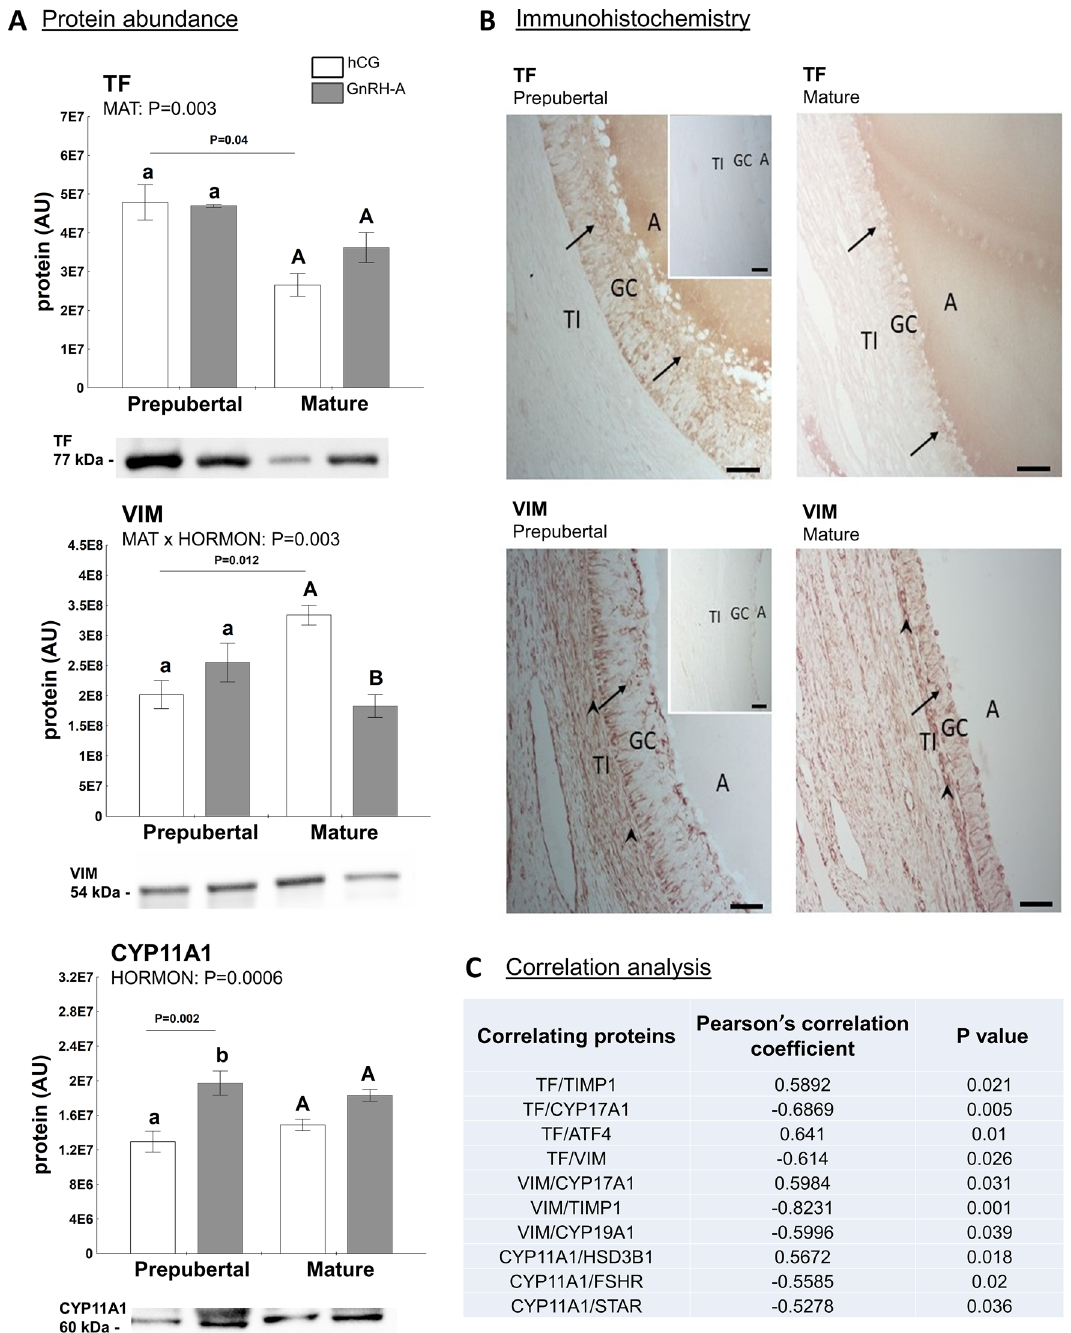
Figure 7. Abundance of proteins (TF, VIM and CYP11A1) in follicular walls of treated gilts, selected for validation of 2D-DIGE by Western blot ( A ) and immunohistochemistry ( B ). ( A ) Protein levels were normalized to total protein content (AU) using TGX Stain-Free gel technology. Uncropped blots are presented in Supplementary Fig. 3D online. Data were analyzed using two-way ANOVA with Tukey post-hoc tests and are presented as mean ± SEM (n = 5–6 per group). Means with different superscripts differ significantly (small letters—prepubertal gilts, capital letters—mature gilts; P < 0.05). Line with a P value denote significant differences between prepubertal and mature gilts. AU – arbitrary units. ( B ) TF and VIM immunostaining was performed in large antral follicles of prepubertal and sexually mature gilts. The arrow indicates positive staining in granulosa cells (GC); the arrowhead indicates positive staining in theca cells. Control sections in which the primary antibody was replaced by rabbit or mouse IgG were free from staining (insets). A—antrum, TI— theca interna ; scale bars represent 50 µm. ( C ) Correlations between proteins selected for validation and other factor tested in follicular walls of treated